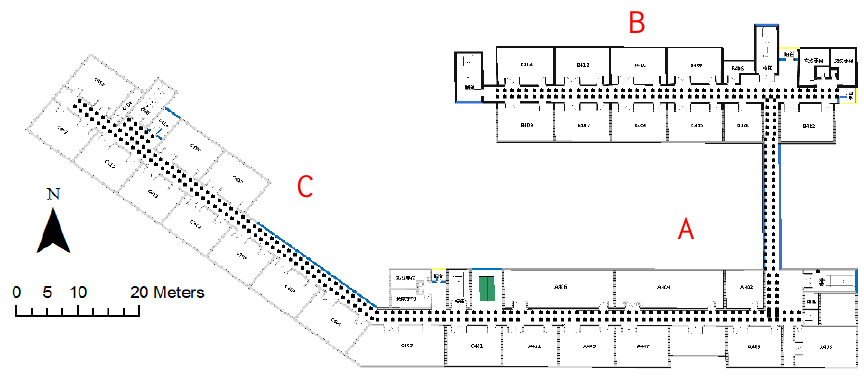
Figure 2. Distribution of fingerprint points.